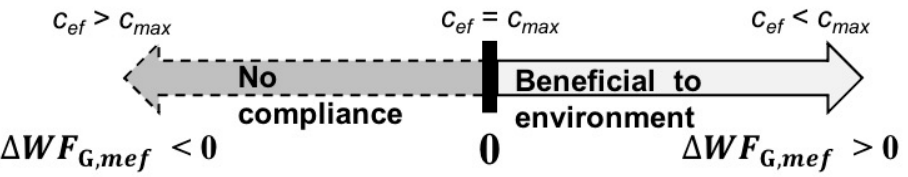
Figure 2. Operational grey water footprint ( ∆ WF G,mef ) scenario.